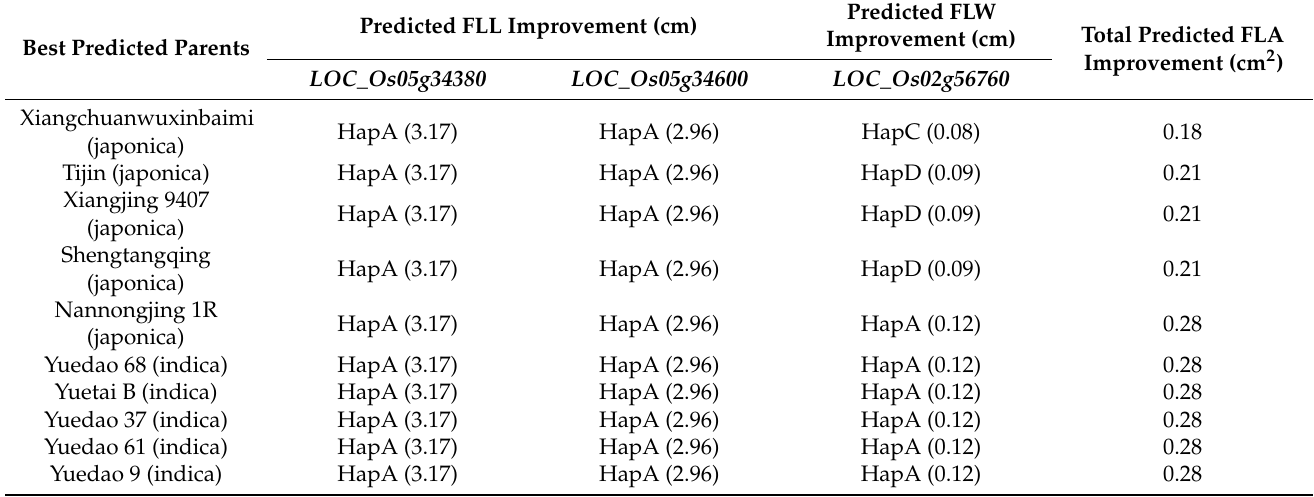
Table 3. Excellent parents predicted for flag leaf shape